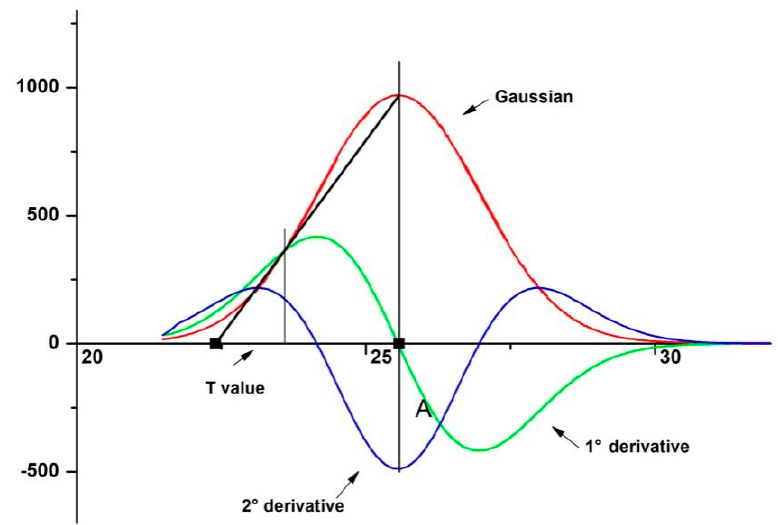
Figure 4. Peak deconvolution used in the microfibrillar angle calculation.